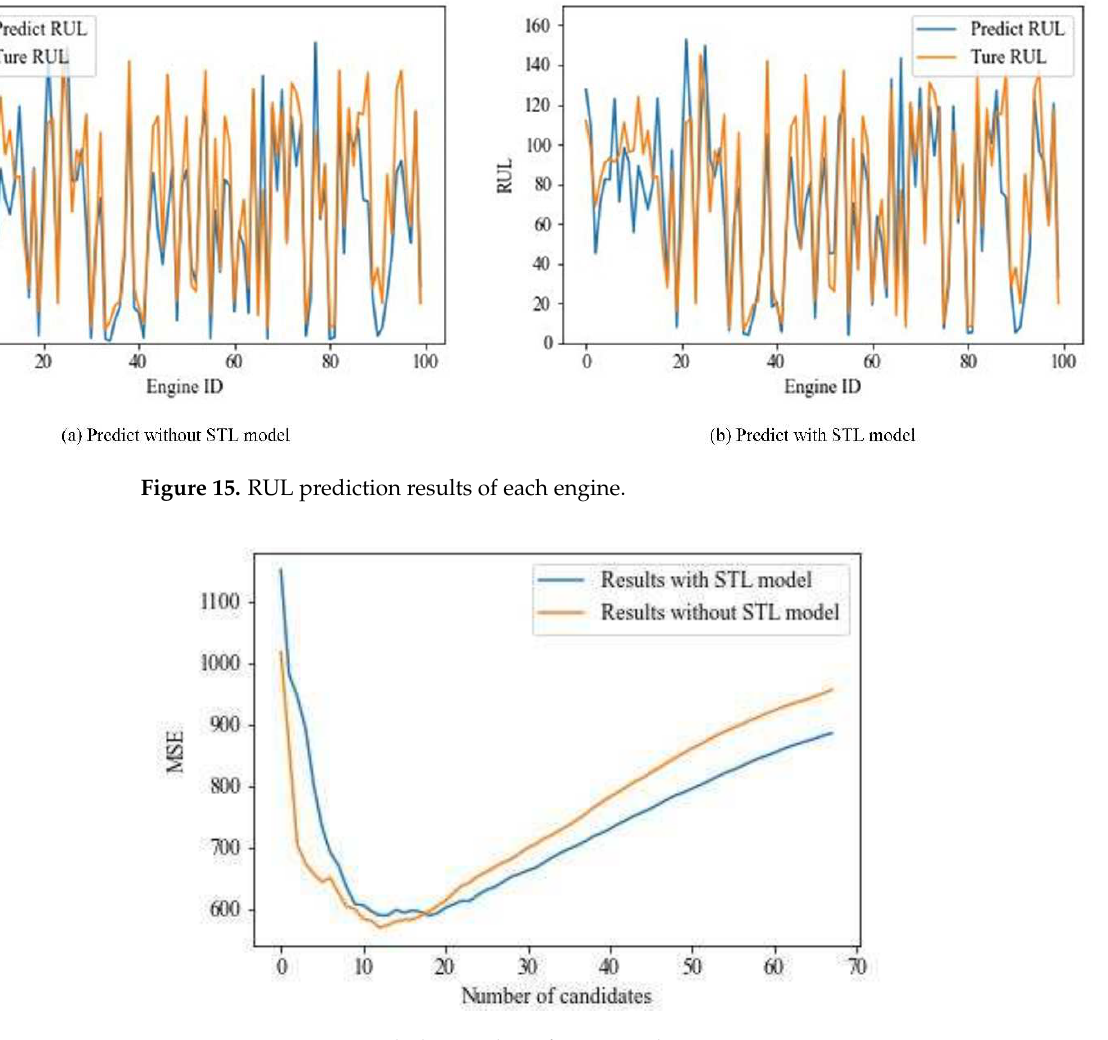
Figure 16. MSE curve with the number of most similar trajectories. Table 5. Comparison test